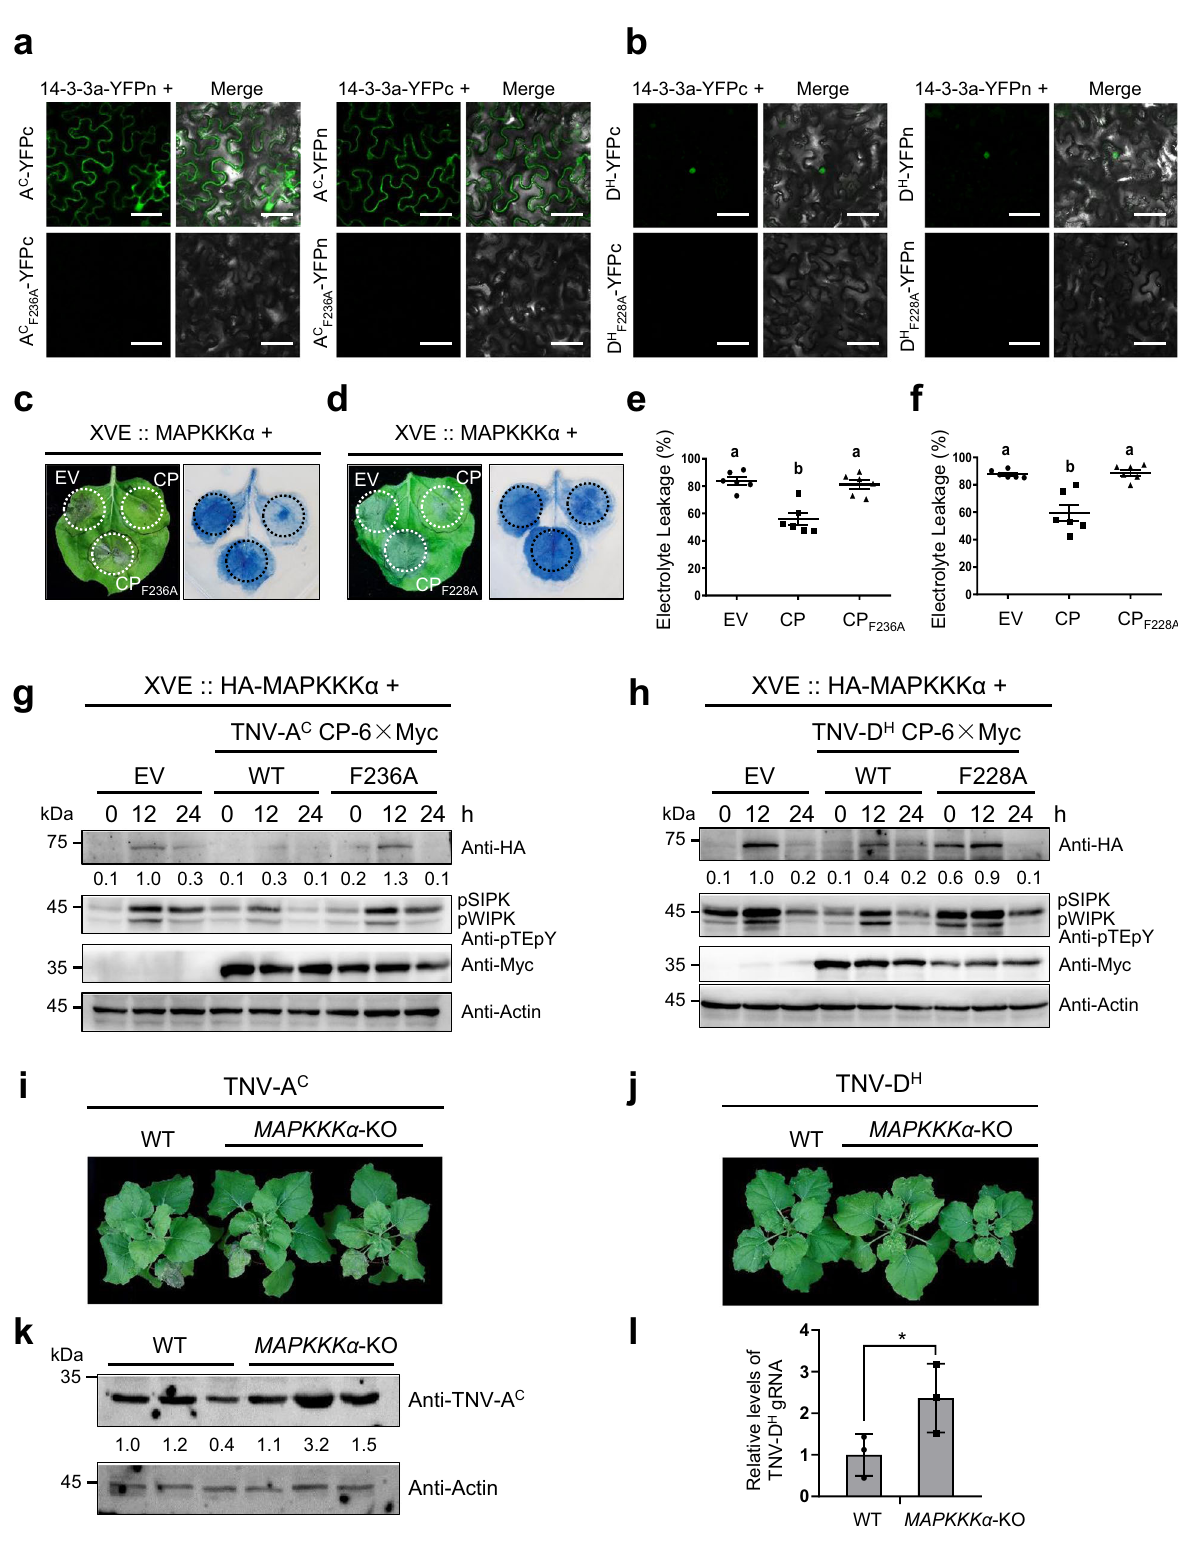
XopN from Xanthomonas campestris pv. vesicatoria interacts with a tomato atypical receptor-like kinase 1 (TARK1) and TFT1 to suppress PTI 76,77 . Here, for the fi rst time, we demonstrate that 14-3-3a is targeted by a viral CP effector. Based on our fi ndings, we propose a model illustrating the MAPKKK α - mediated defense against viruses and how viral CP